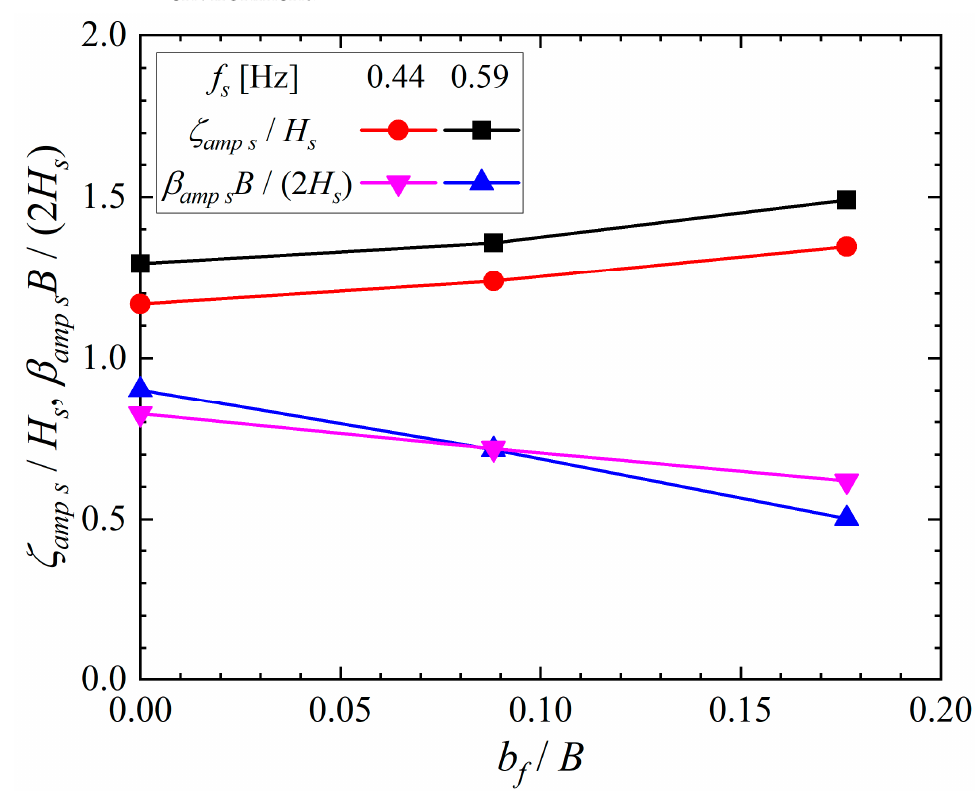
Figure 23. Significant total amplitude of the heave ζ amps and pitch β amps .